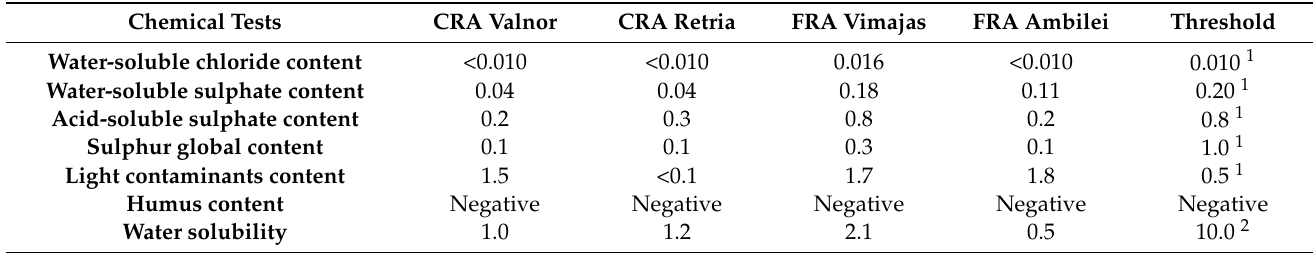
Table 4. Results of the chemical tests of the recycled aggregates.